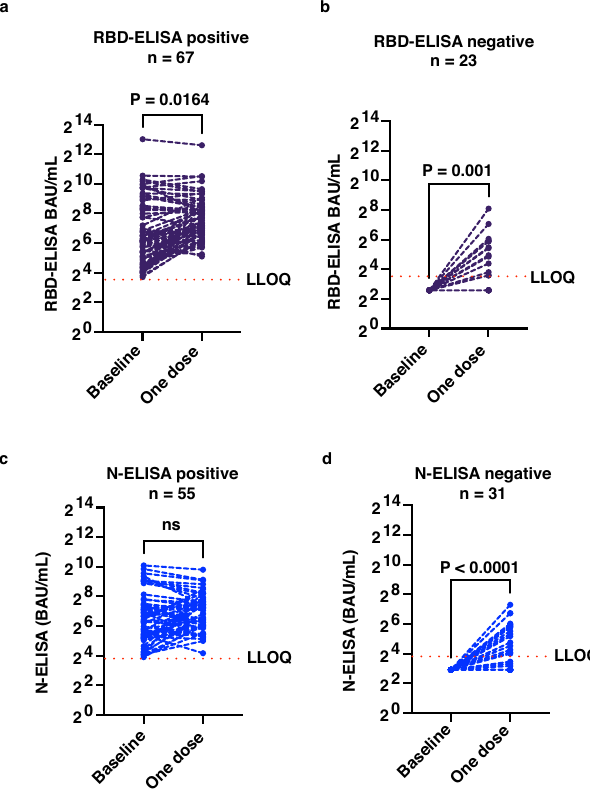
Fig. 1 Booster effect of a single dose of BBV152 vaccination. Geometric mean titers of antibodies against SARS-CoV-2 RBD were estimated by quantitative RBD-ELISA and data presented as geometric mean with 95% con fi dence intervals at baseline and after one dose in a RBD-ELISA-positive samples at baseline ( n = 67 independent values) or b RBD-ELISA-negative samples at baseline ( n = 23 independent values). c Geometric mean titers of antibodies against SARS-CoV-2 Nucleocapsid (N) were estimated by quantitative N-ELISA and data presented as GMT at baseline and after one dose in c N-ELISA-positive samples at baseline ( n = 55 independent values) or d N-ELISA-negative samples at baseline ( n = 31 independent values). Data were expressed as binding antibody units (BAU)/ml (international units). Dotted line indicates the lower limit of quantitation (LLOQ) which is 12 BAU/mL for RBD-ELISA and 15 BAU/mL for N-ELISA. Two-tailed P values were estimated by Wilcoxon matched-pairs signed-rank test in a – d . ns: Not signi fi cant. Source data are provided as a Source data fi